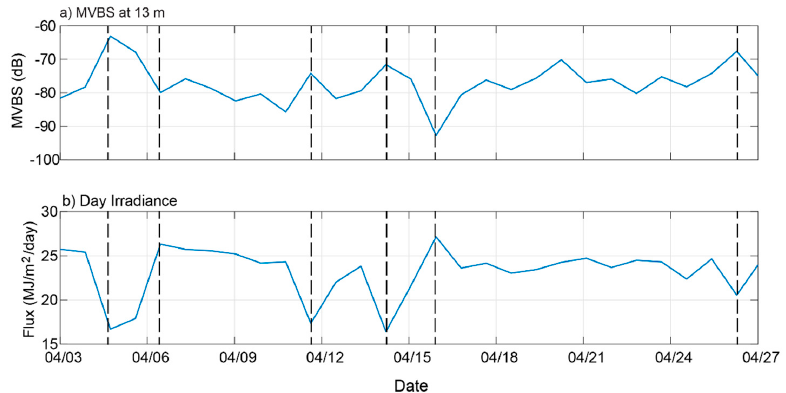
Figure 11. Daytime distribution on the MVBS at 13 m of depth vs. solar irradiance. The dashed lines mark major MVBS peaks and their correspondence in irradiance.